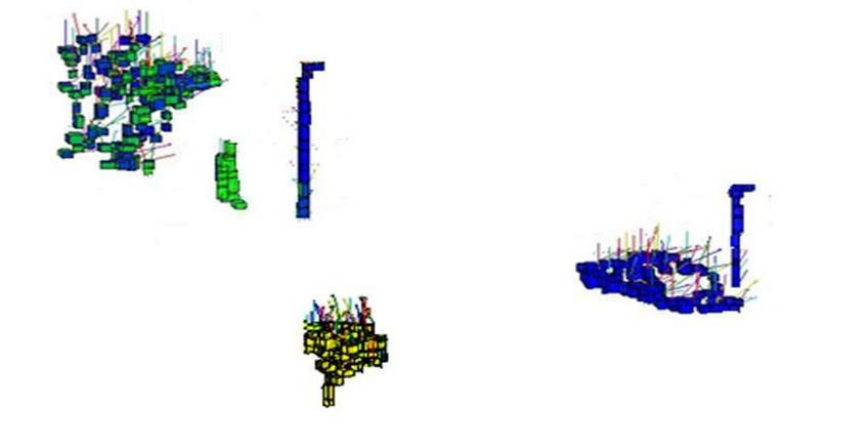
Figure 3. Segmented objects in a scene with prior ground